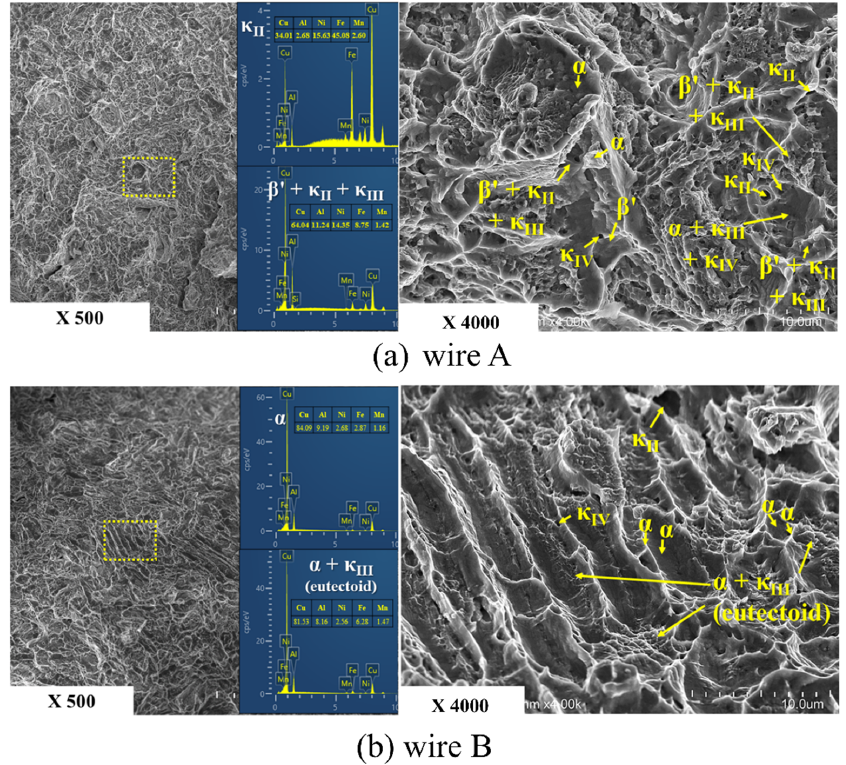
Figure 9. Fracture morphology of the tensile sample and EDS analysis results of ( a ) wire A; ( b ) wire B.